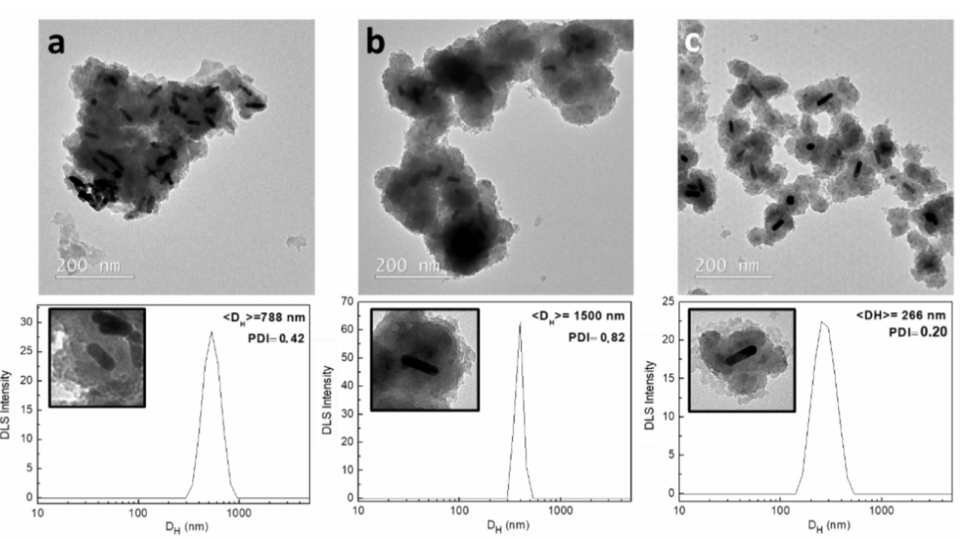
Figure 4. TEM images and hydrodynamic sizes measured by the DLS of hybrid nanoparticles obtained with different shaking conditions: ( a ) static, ( b ) magnetic stirring, and ( c )